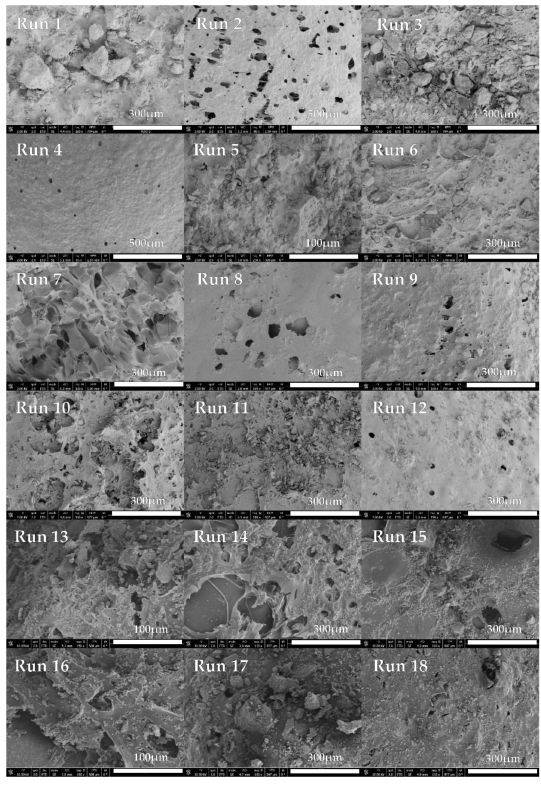
Figure 11. SEM images of foams